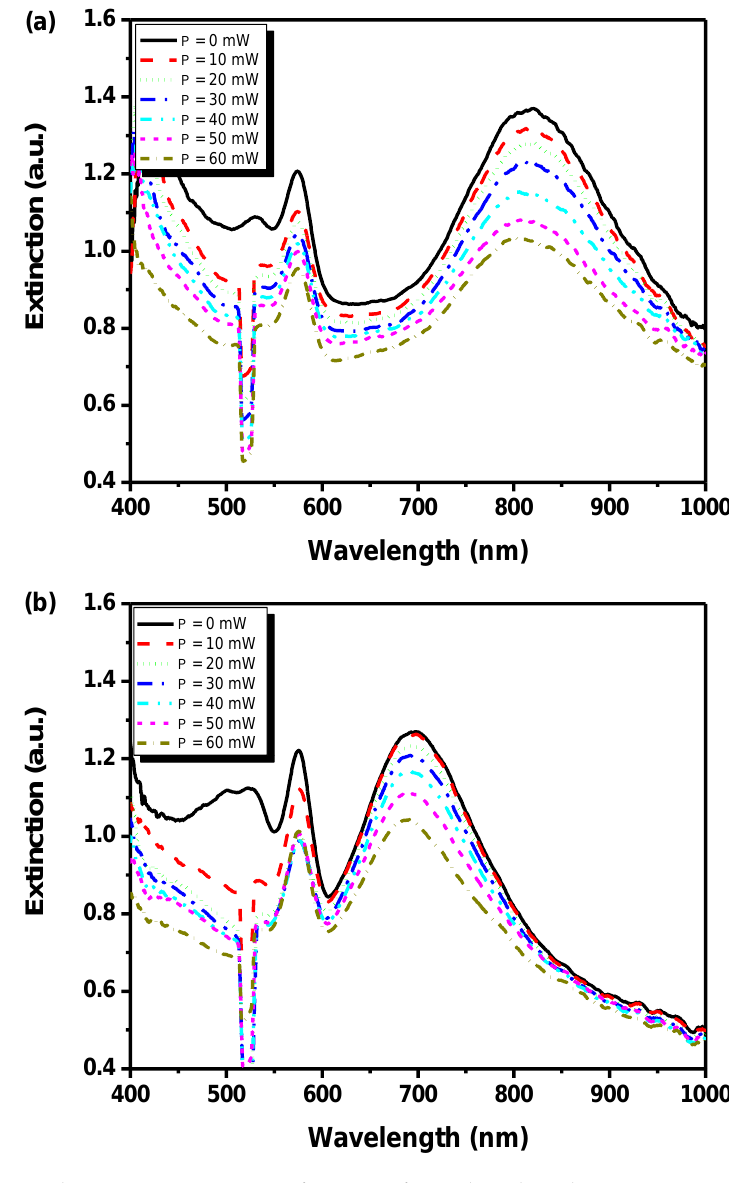
Figure 8. Measured extinction spectra as a function of wavelength with varying pumping power for ( a ) coupled system (nanodisks with HPDLCs transmission gratings), and ( b ) uncoupled nanodisks (separated from HPDLCs transmission gratings). Reproduced with permission from [109]. Copyright American Chemical Society, 2011.